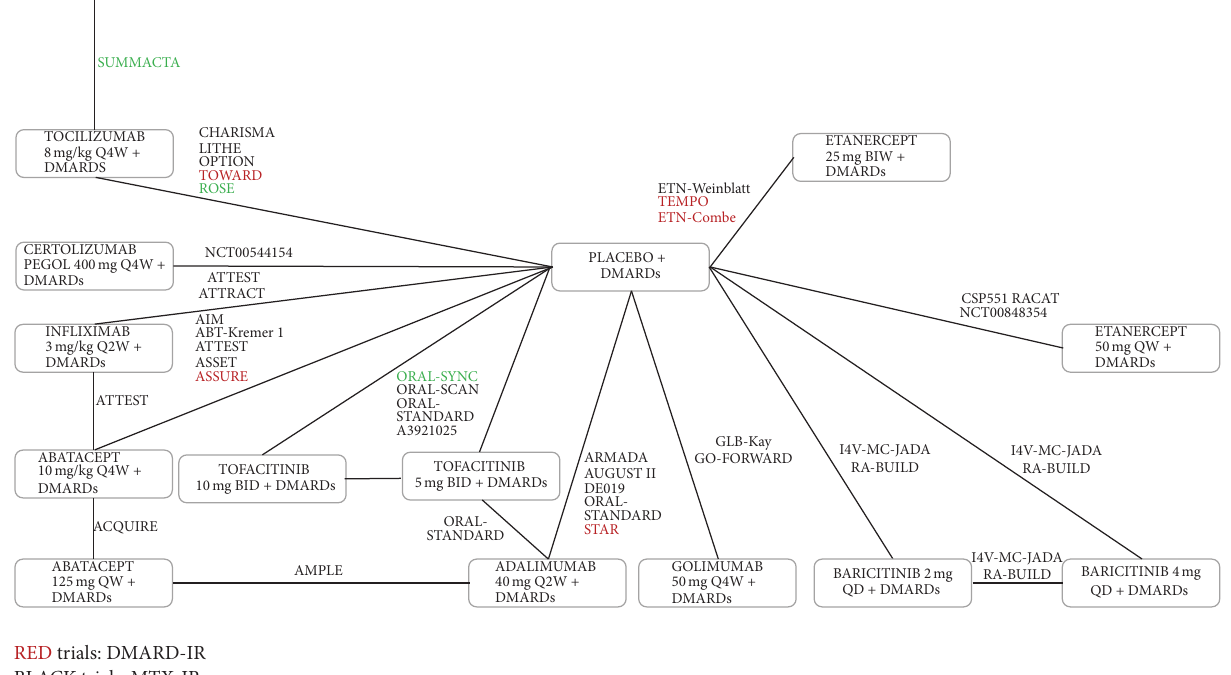
Figure 3: Combination therapy evidence